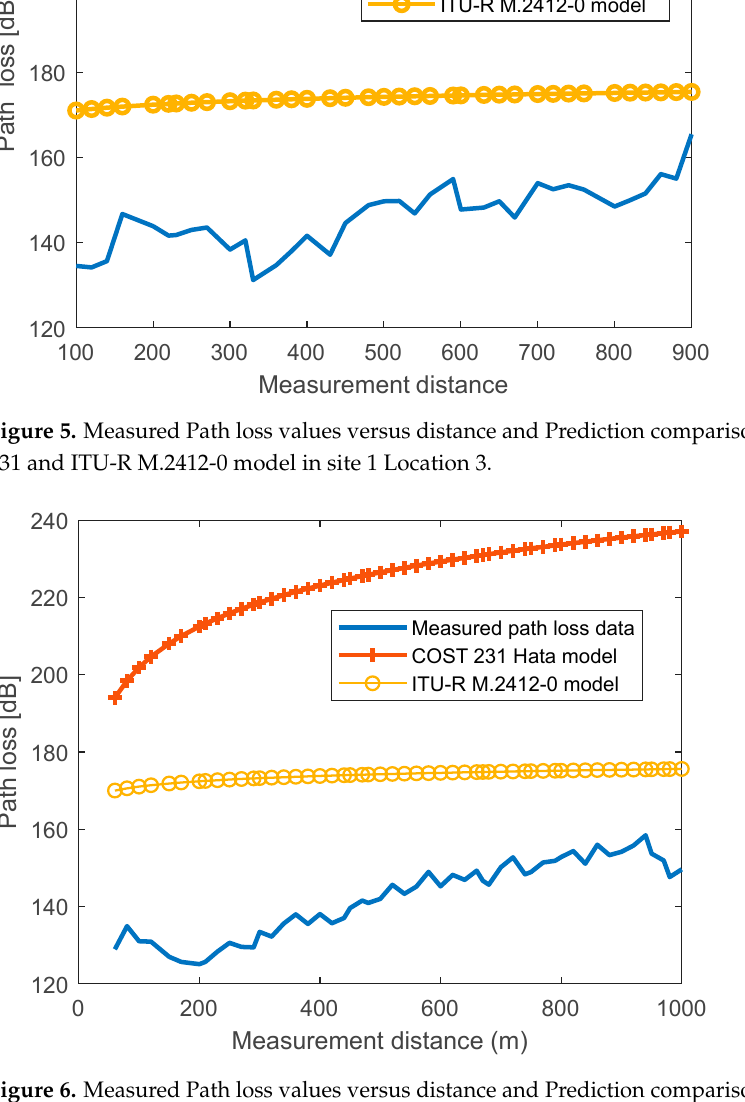
Figure 6. Measured Path loss values versus distance and Prediction comparison with standard COST 231 and ITU-R M.2412-0 model in site 1 Location 4.